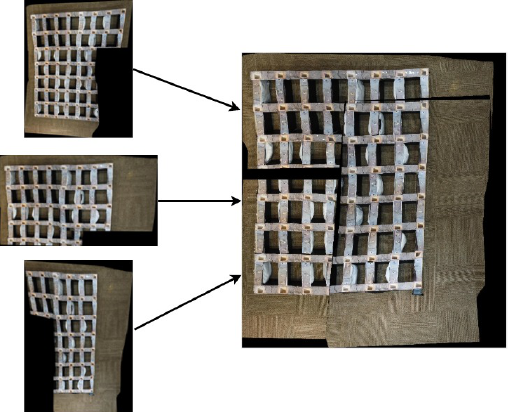
Figure 11. Stitching the drone’s RGB footage recorded in the lab environment.